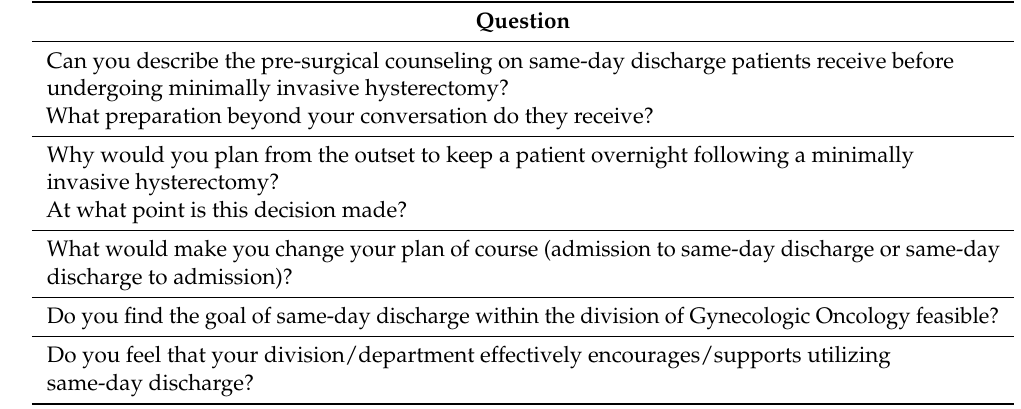
Table 1. Example Interview